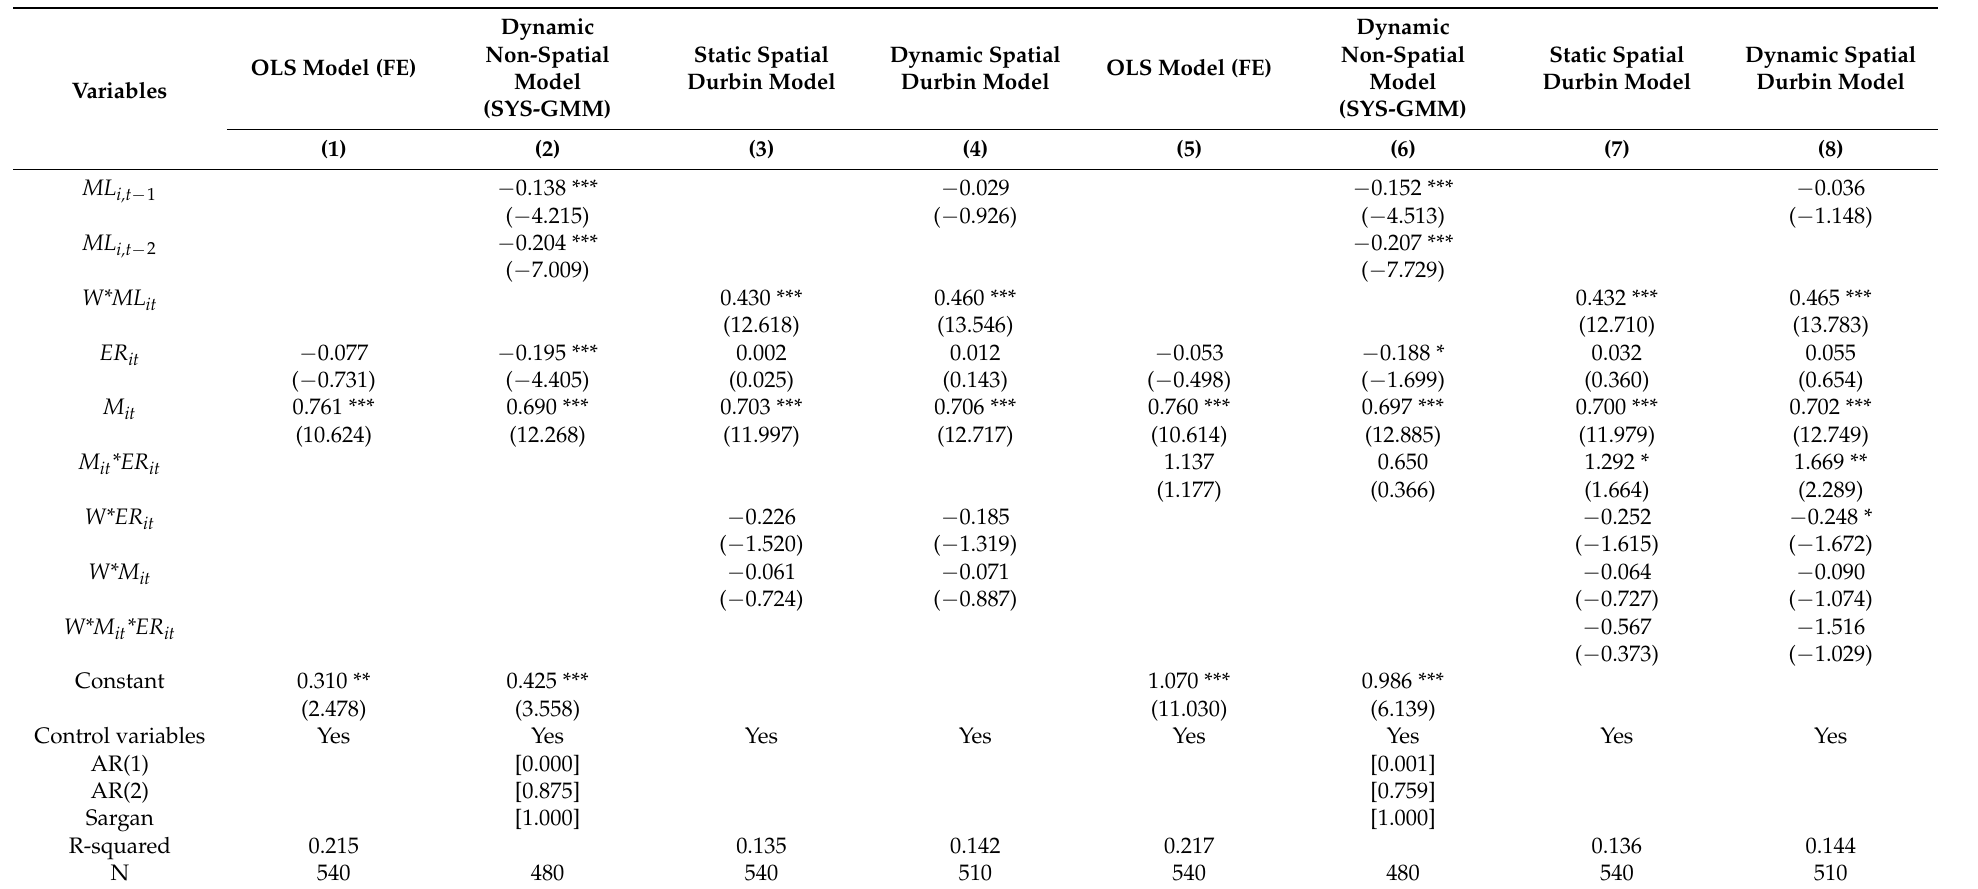
Table 7. The moderating results of efficiency change for the nexus between public-participation environmental regulation and green